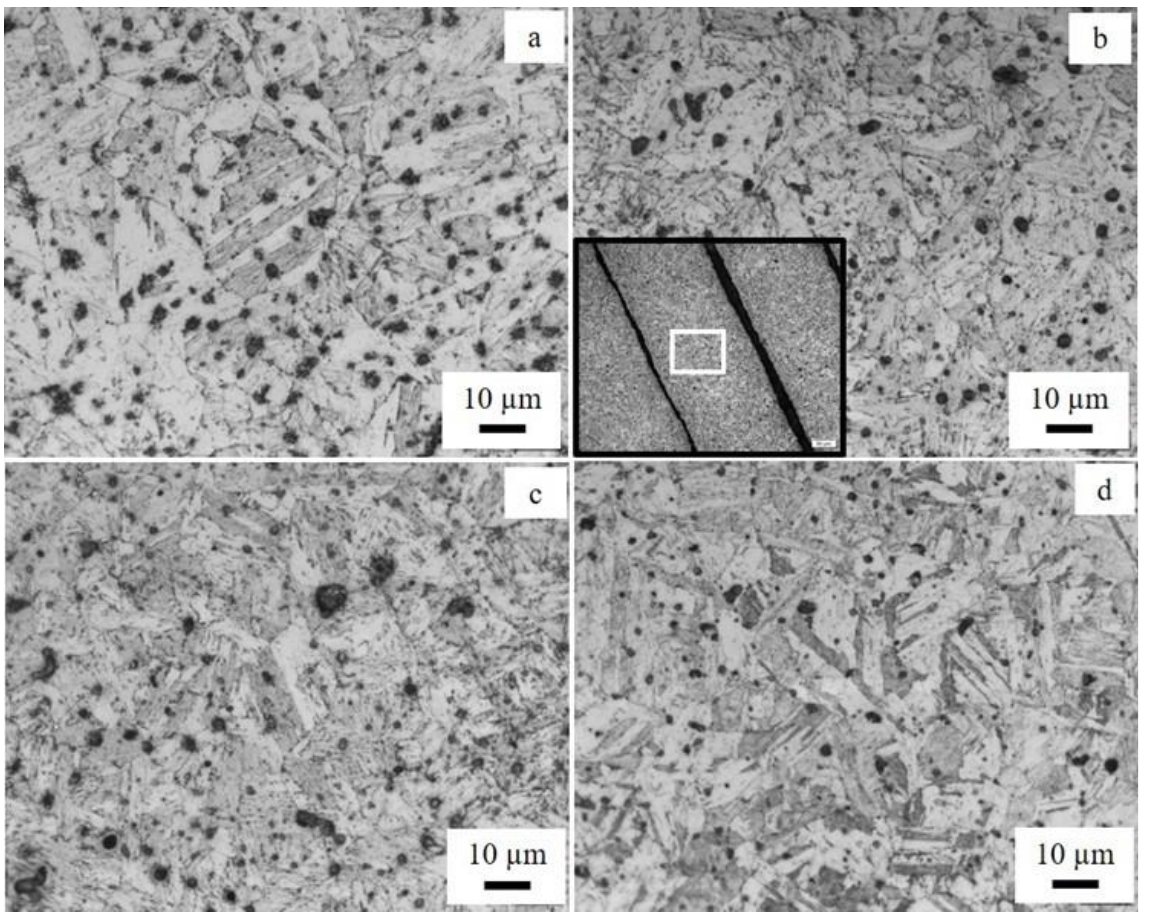
Figure 9. LOM images of heat-treated samples: ( a ) SA, ( b ) H1A, ( c ) H2A, and ( d ) H1Q. The inset in Figure 9b is a small-magnification image showing regions where the magnified images were recorded. The voids between the filaments appear as a dark contrast. The white square in the inset is the approximate location from where the magnified image of Figure 9b was acquired. 323